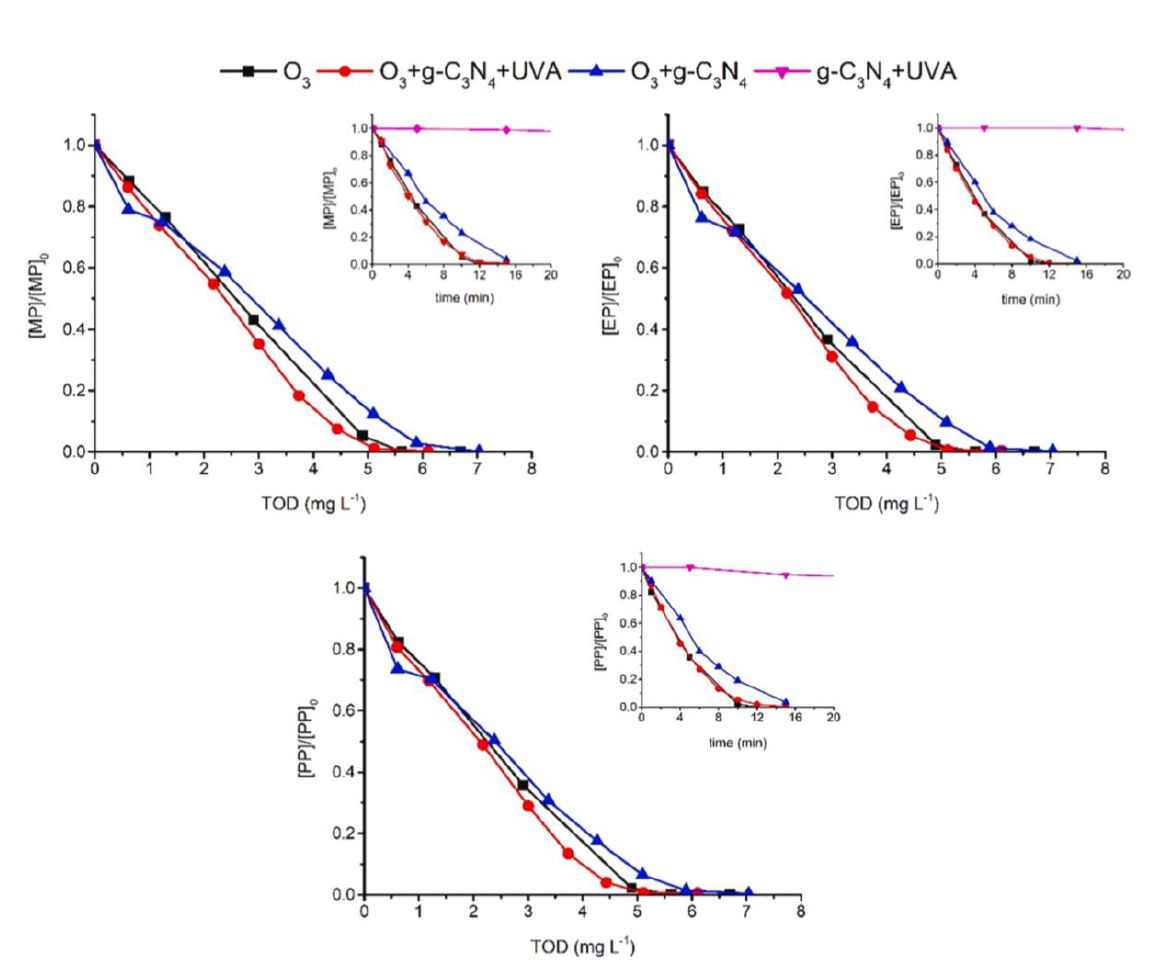
Figure 14. Degradation of methyl-, ethyl- and propylparaben over photocatalytic oxidation and photocatalytic, catalytic, and single ozonation process. Reproduced with permission from ref. [65]. Copyright 2022 Elsevier.